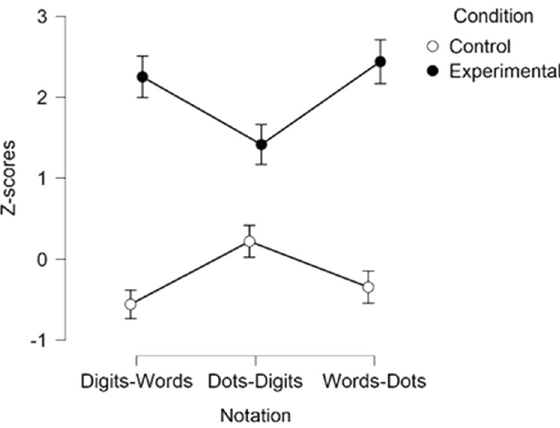
Figure 4. Z-scores for the mixed notation trials, depicted per condition across all electrode sides. Vertical bars denote Standard Errors